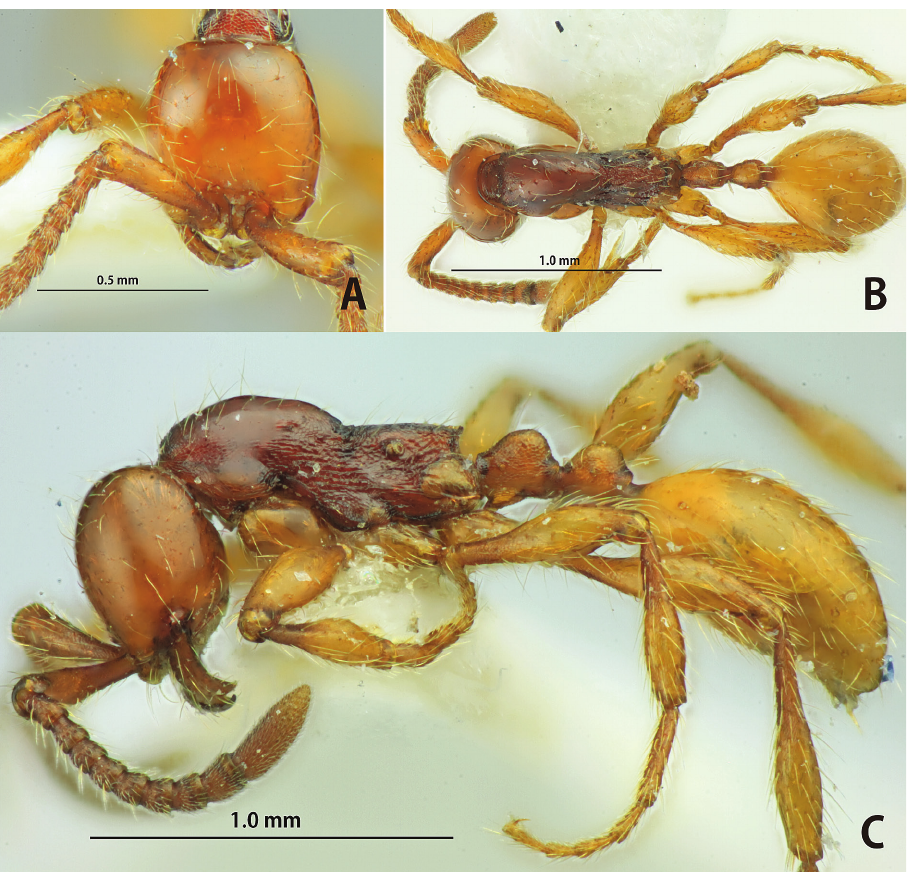
Figure 15. Aenictus pilosus (holotype). A Head in full-face view B body in dorsal view C body in junction angulated, nearly right-angled; declivity of propodeum shallowly concave, and encircled with a rim; metapleural gland bulla relatively large, its maximum diam- eter about 2.5 times as long as distance between propodeal spiracle and metapleural gland bulla. Petiole slightly longer than high, elevated posteriorly; subpetiolar process generally very low, with its anteroventral corner acutely angulate, and ventral margin feebly concave. Postpetiole slightly smaller than petiole, with its dorsal outline convex. Head and gaster smooth and shiny; basal half of antennal scape densely microretic- ulate but apical half smooth and shiny; mandible finely striate. Promesonotum smooth and shiny except for anteriormost portion punctate; mesopleuron with slightly irregular rugae; metapleuron, and propodeum wrinkled and reticulate. Petiole entirely reticulate; postpetiole superficially reticulate and shiny. Basal 1/3 of femora sculptured, apical 2/3 (swollen area) smooth and shiny; tibiae microreticulate, partly smooth and shiny. Head and mesosoma dorsally with relatively dense standing hairs; longest pronotal hair 0.33–0.35 mm long; legs with dense long decumbent hairs. Head reddish brown;